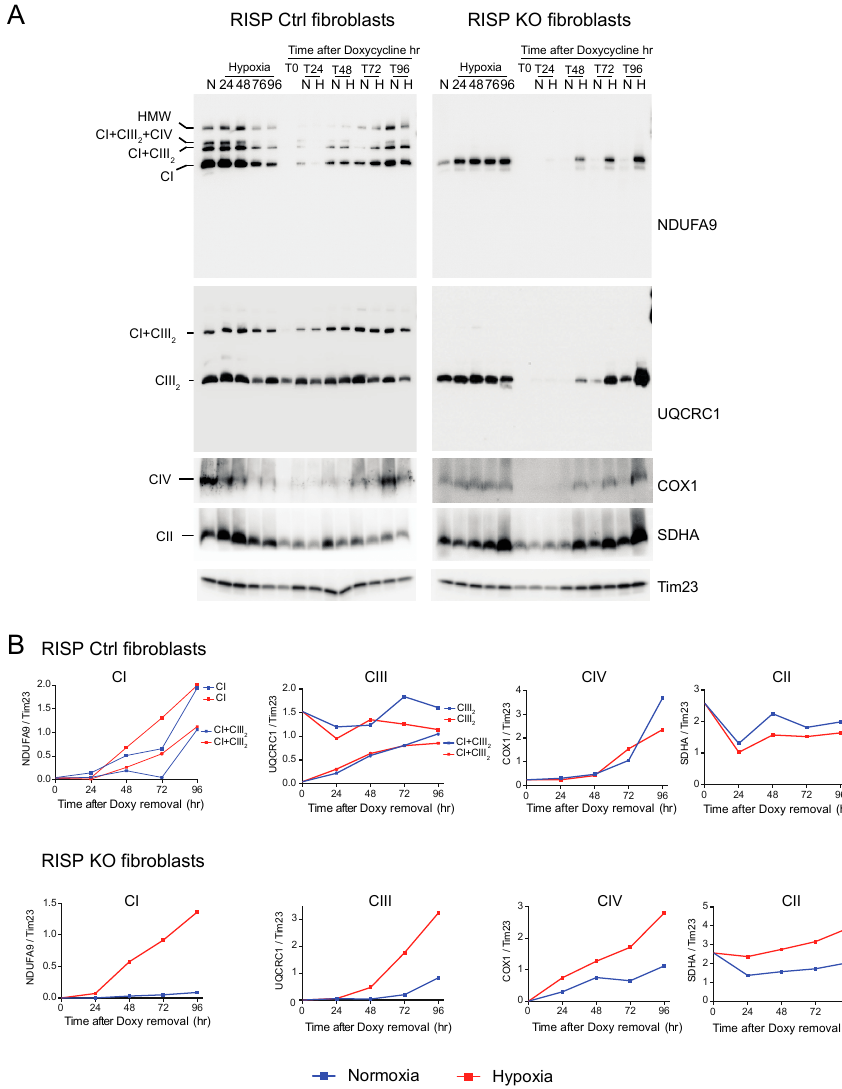
Figure 6. Respiratory complex and supercomplex de novo assembly in normoxia and hypoxia in RISP fibroblasts after doxycycline treatment. ( A ) RISP control and KO lung fibroblasts were treated with 15 μ g/mL doxycycline for 6 days to inhibit mitochondrial protein synthesis and to deplete the organelle of respiratory complexes. The drug was removed (time 0, T0) and cells were exposed in parallel to either normoxia (N, 21% oxygen) or hypoxia (H, 1% oxygen) for different times: 24, 48, 72 and 96 h (T24, T48, T72 and T96 respectively). As a control, untreated fibroblasts were exposed to the different times to hypoxia (24 to 96 h). Respiratory complexes were extracted with digitonin and analyzed by BN-PAGE followed by Western blotting. For Ctrl fibroblasts, two identical blots were run and antibodies sequentially added in the following order, on blot 1: NDUFA9 (CI subunit) and COX1 (CIV subunit), on blot 2: UQCRC1 (CIII subunit) and SDHA (CII subunit). For KO fibroblasts, blot 1: NDUFA9, COX1 and SDHA and on blot 2: UQCRC1. Tim23 was used as loading control. ( B ) The graphs represent the kinetics of assembly of CI, CIII, CIV and CII calculated at the different time points after respiratory complexes depletion by normalizing the NDUFA9, UQCRC1, COX1 and SDHA signals to Tim23 under normoxia (blue) or hypoxia (red) from blots shown in ( A ) using ImageJ software ( n = 1). In the RISP KO fibroblasts, de novo assembly of all respiratory complexes over time was faster in 1% oxygen when compared to normoxia. In control cells, there were no di ff erences in assembly of respiratory complexes between normoxia and